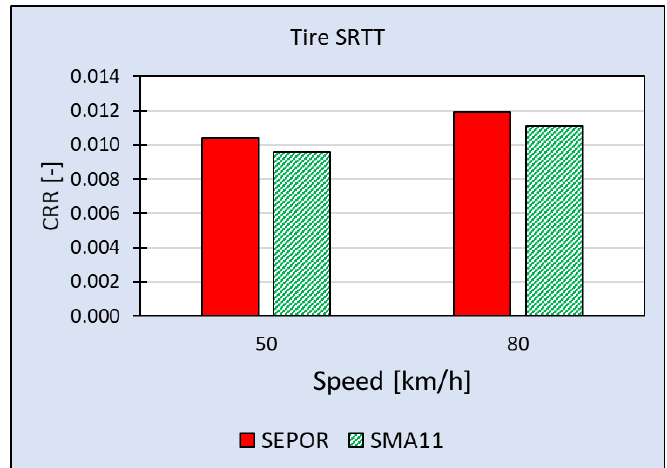
◦ ◦ C and 20 C ◦ C. Although